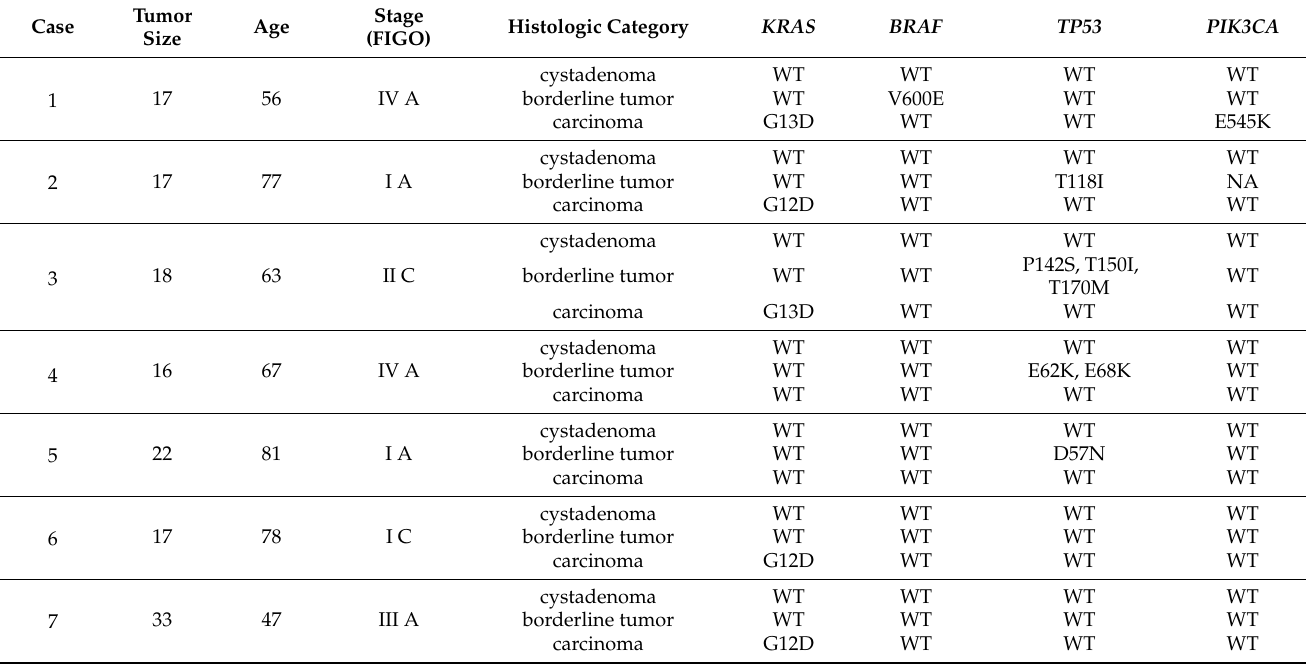
FIGO, International Federation of Gynecology and